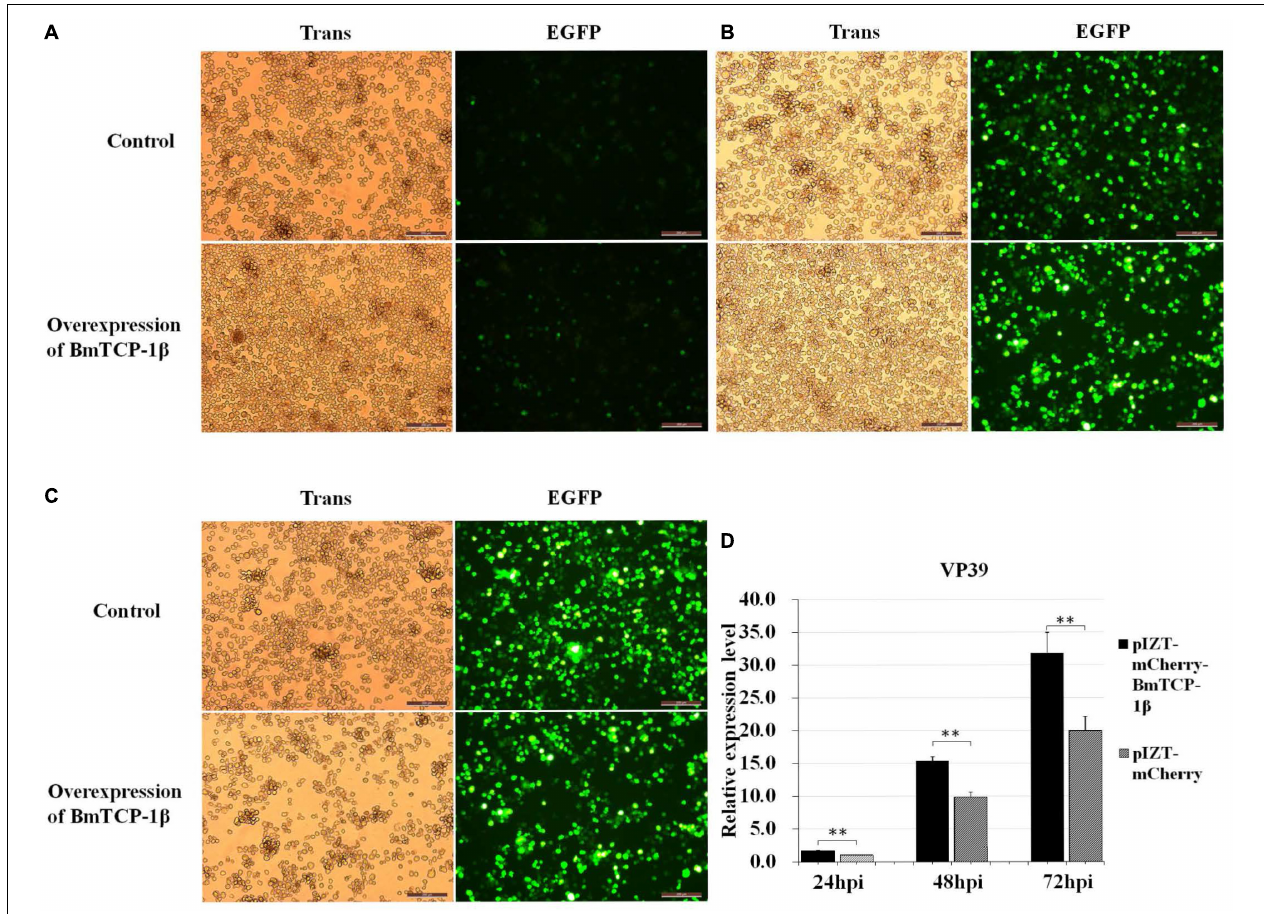
FIGURE 6 | Infection analysis of BmNPV in wild type and transgenic BmN cells. (A) 24 h after BV-EGFP infection. (B) 48 h after BV-EGFP infection. (C) 72 h after BV-EGFP infection. Scale bar = 200 µ m. (D) replication analysis of BmNPV following the overexpression of BmTCP-1 β . The data was analyzed as described above. One-way ANOVA with Tukey’s posttest was used. Significant differences are indicated by asterisks ( p < 0.05).